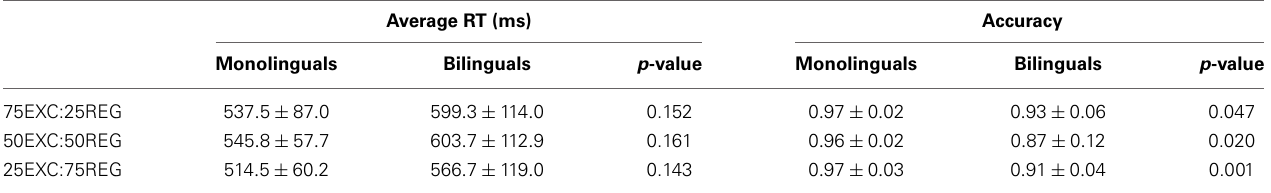
Table 1 | Mean ± Std of average reaction time (RT) and accuracy of monolinguals and bilingual groups for reading the three lists.